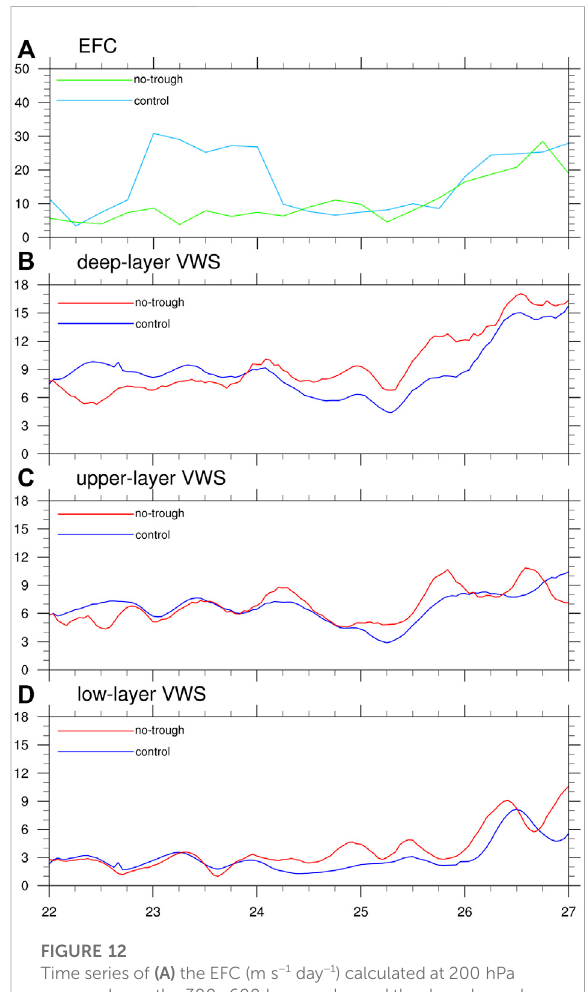
FIGURE 12 Time series of (A) the EFC (m s − 1 day − 1 ) calculated at 200 hPa averaged over the 300 – 600 km annulus and the deep-layer shear (B) between 200 and 850 hPa (m s − 1 ), upper-layer shear (C) between 200 and 500 hPa (m s − 1 ), and low-layer shear (D) between 500 and 850 hPa (m s − 1 ) in CTRL (blue) and No-trough (red),